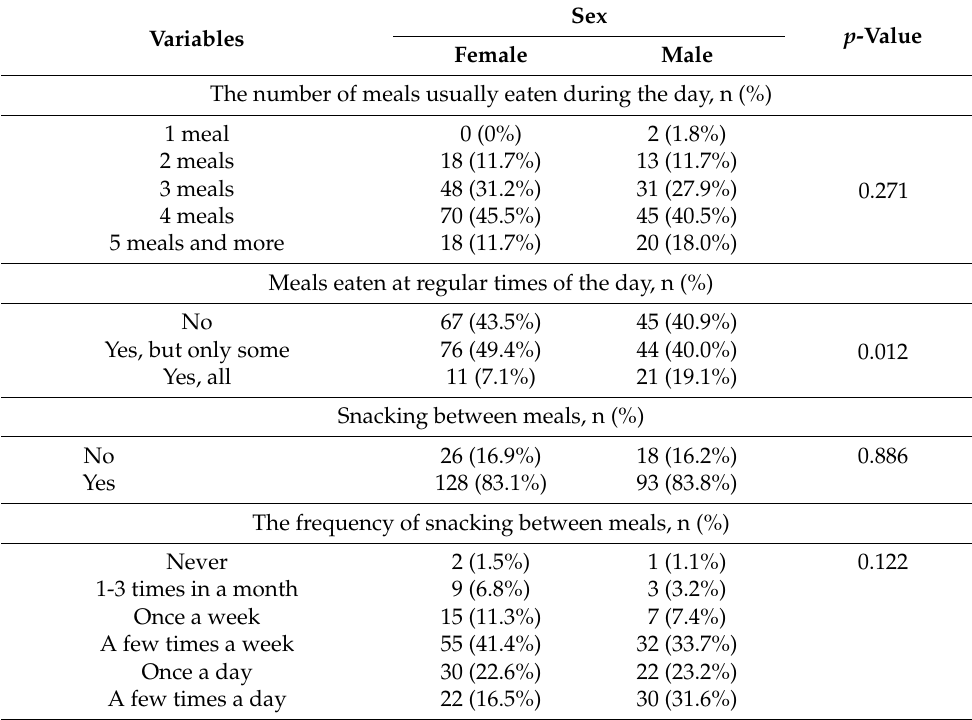
Table A1. Women and men’s eating